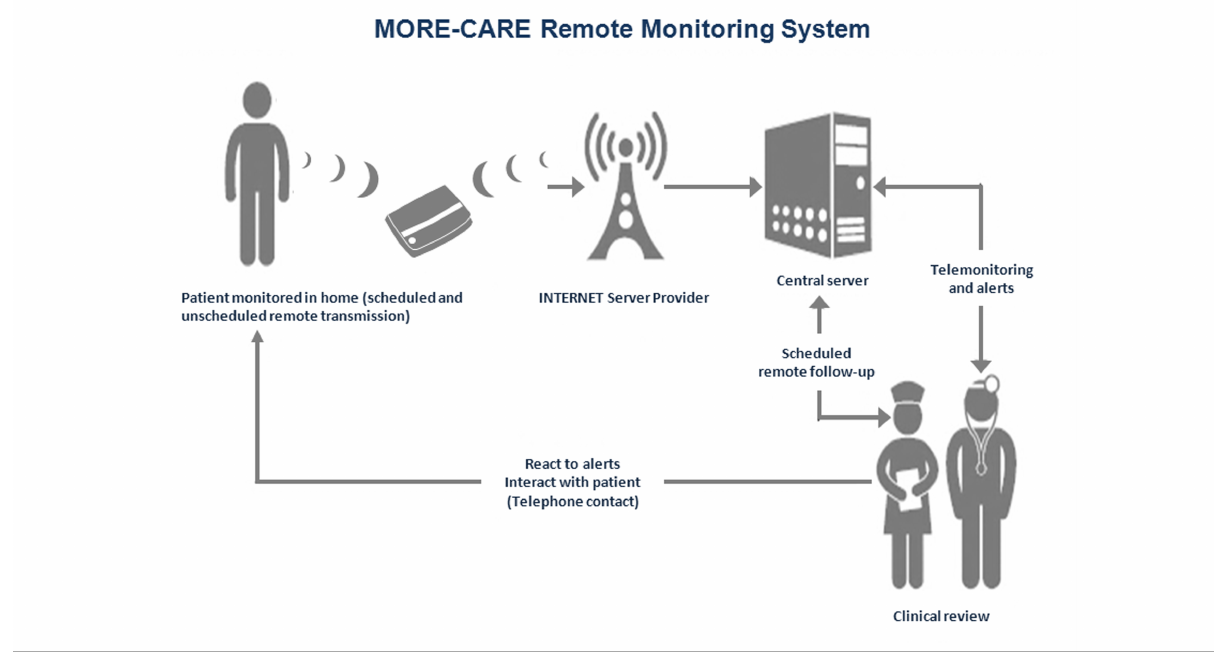
Figure 2. Scheduling of follow-up in the Remote group (with RM and in-office follow-up) and in the Control group (with in-office follow-up